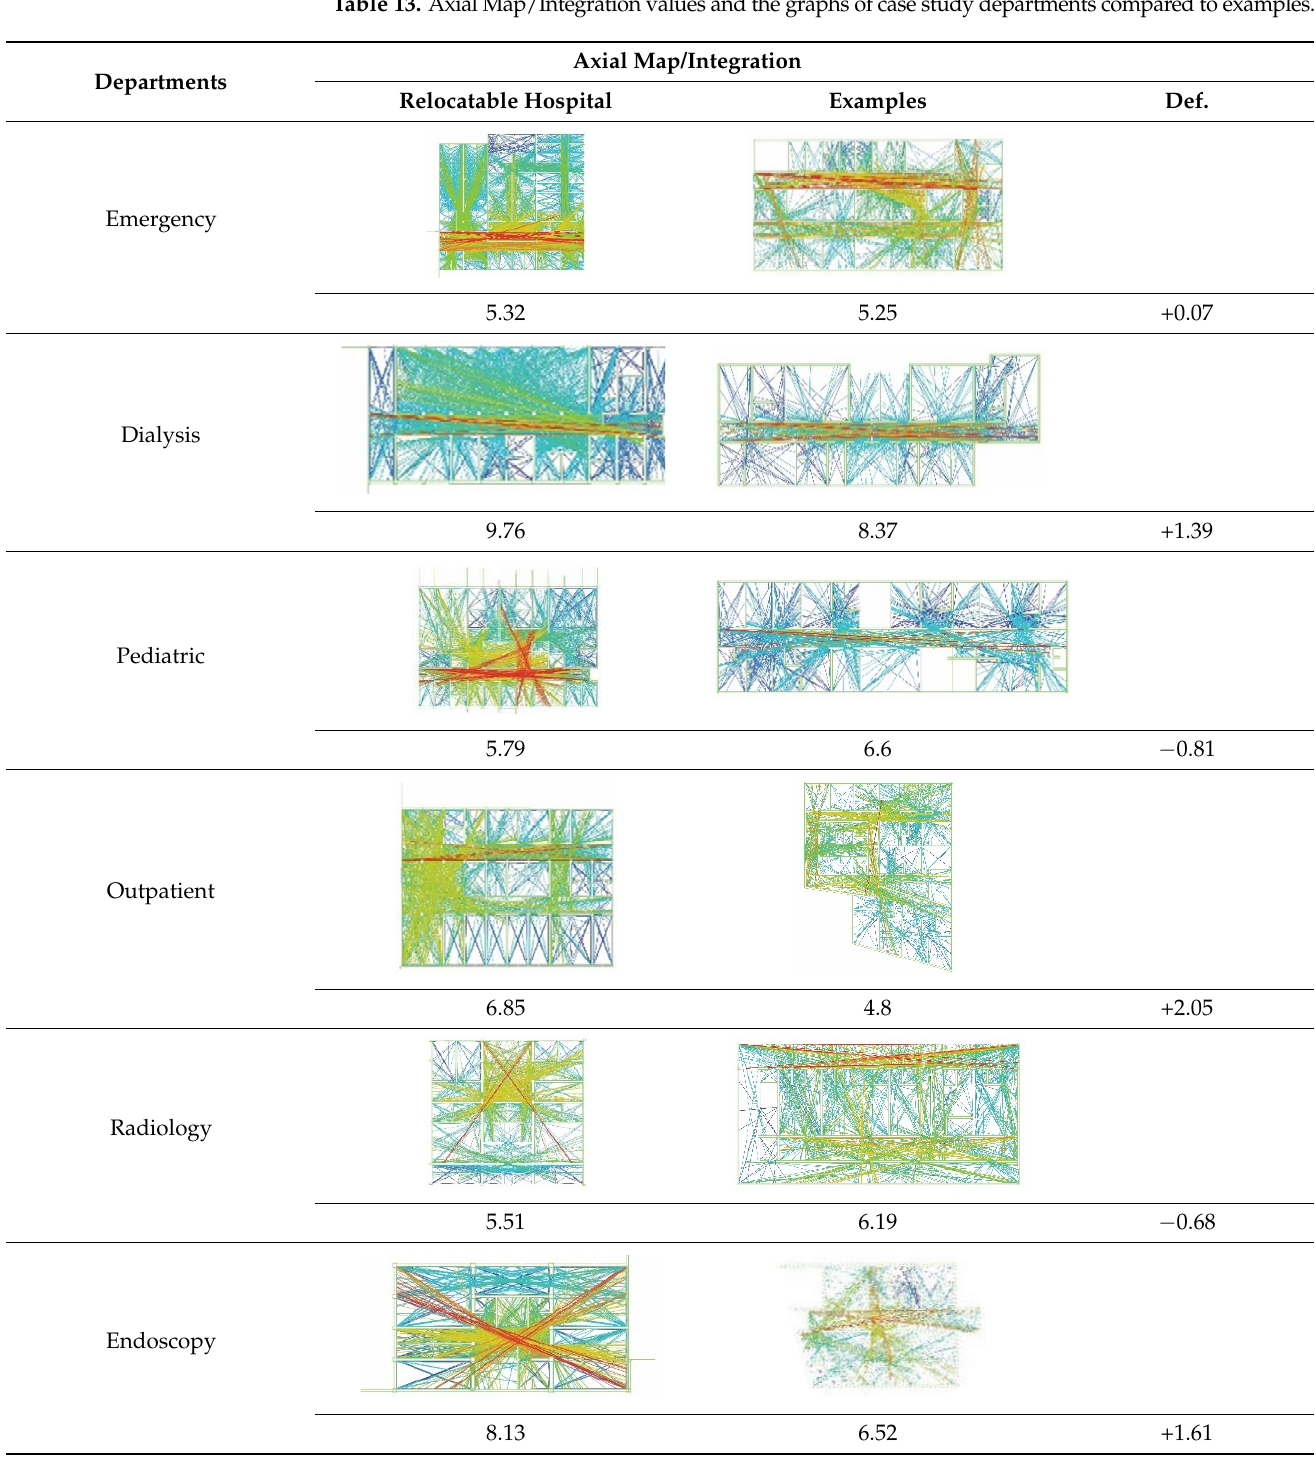
Table 13. Axial Map/Integration values and the graphs of case study departments compared to examples.